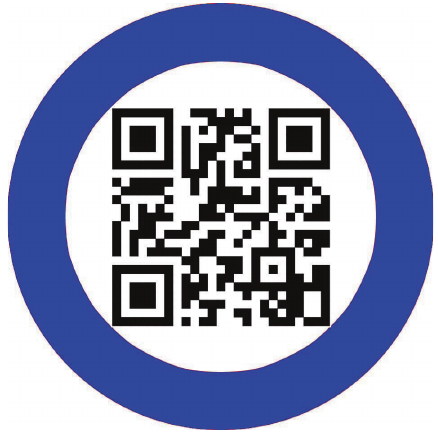
Figure 1: QR Code-based artificial object